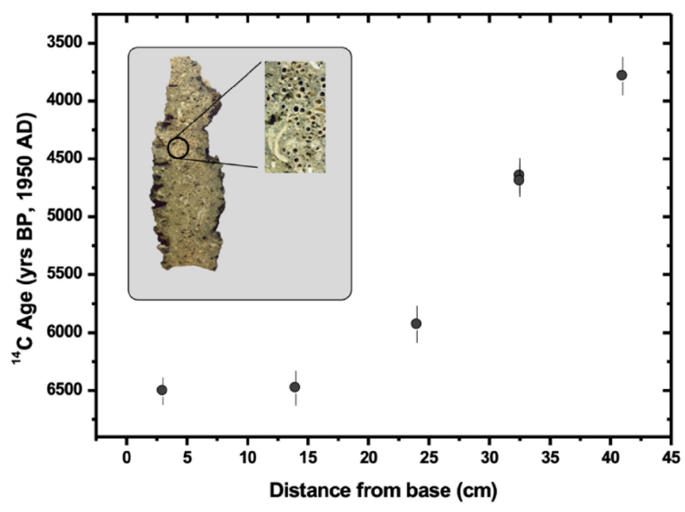
Figure 6. One of the analysed bio-formations from “Lu Lampiune cave” with a closeup view of its inner texture. The graph shows the calibrated radiocarbon age for the sample taken along the longitudinal axis of the pseudo-stalactite as a function of the distance from the base.